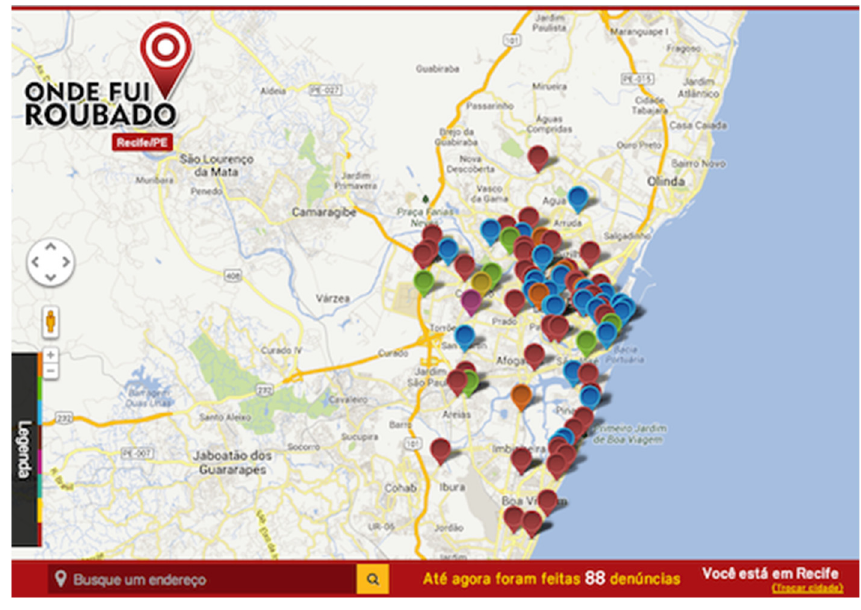
Figure 1. The platform ‘Onde fui roubado’.